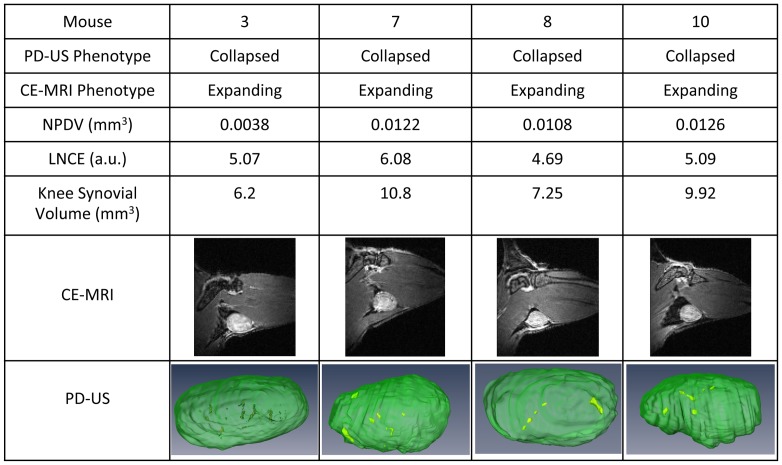
Discordant PLN phenotyping by CE-MRI and PD-US.TNF-Tg mice (ages 6–11 months) were phenotyped as collapsed by PD-US as described in Figure 6 and then underwent CE-MRI. The 4 of 12 PLN that phenotyped as collapsed via PD-US and expanding via CE-MRI are shown. Note the large synovial volumes present in the adjacent knee, a hallmark of arthritic flare and PLN collapse.